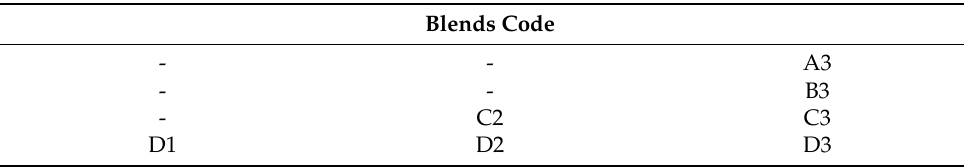
Table 5. Blends code for all the investigated